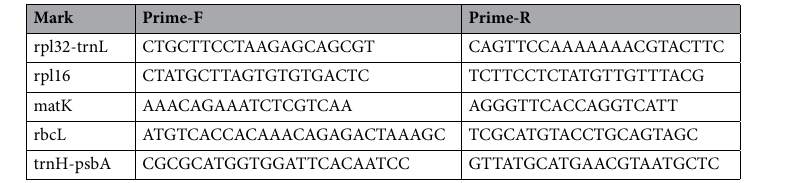
Table 2. Sequences of the five primers used in this